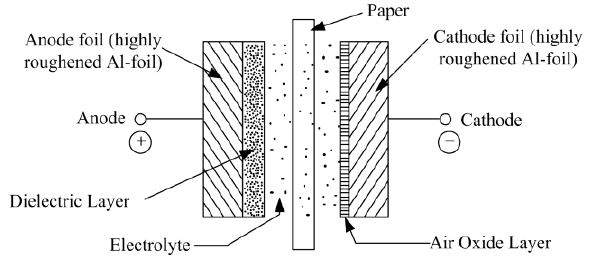
Figure 2. Structure of electrolytic capacitor.